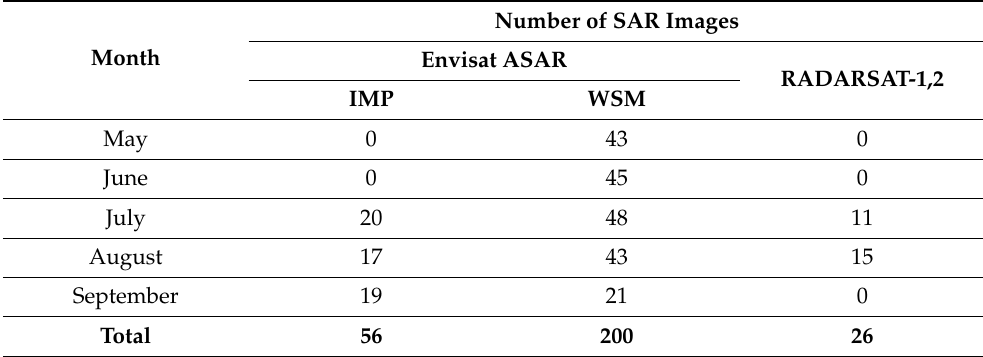
Table 1. Number of SAR images by month, covering the White Sea in 2007–2013. Number of SAR Images Month Envisat ASAR RADARSAT-1,2 IMP WSM May 0 43 0 June 0 45 0 July August September Total 56 200